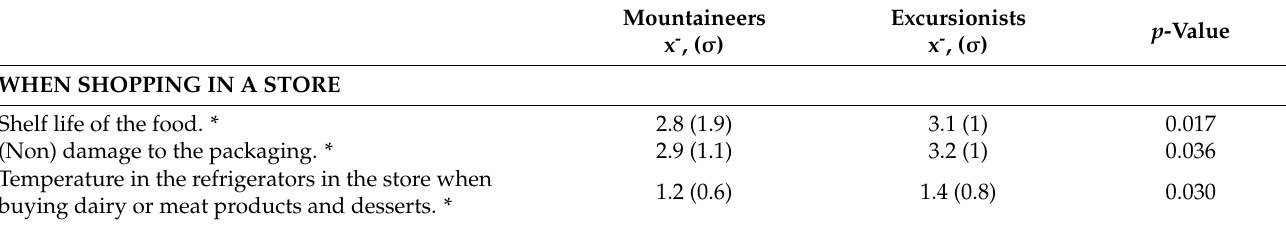
Table 4. Measures for purchasing food and preparing food at